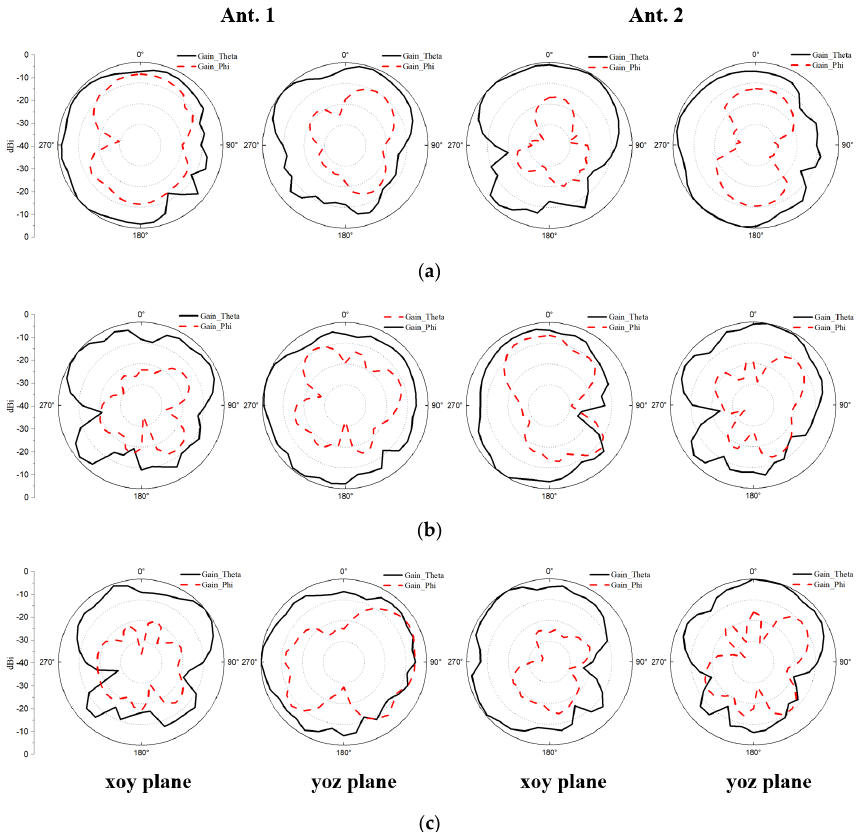
Figure 13. Measured 2D radiation patterns of Ant. 1 and Ant. 2 at ( a ) 3.5 GHz. ( b ) 4.9 GHz. ( c ) 5.5 GHz. In Table 1, the proposed eight-element antenna array not only has the advantage of the comprehensive performance, but also has a minimized size. Therefore, it can be well employed in the future triple-band ultra-thin 5G mobile phones. Table 1. Comparison of the 5G MIMO smartphone antennas.